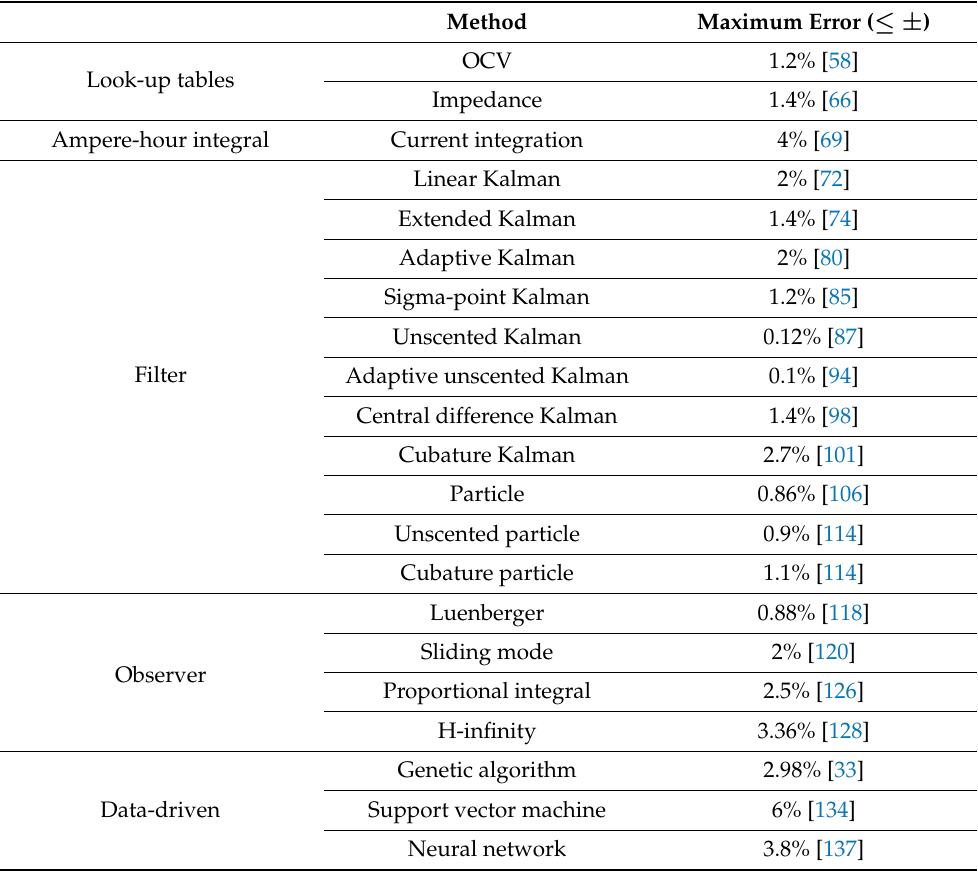
Table 1. The comparison of SoC estimation methods for